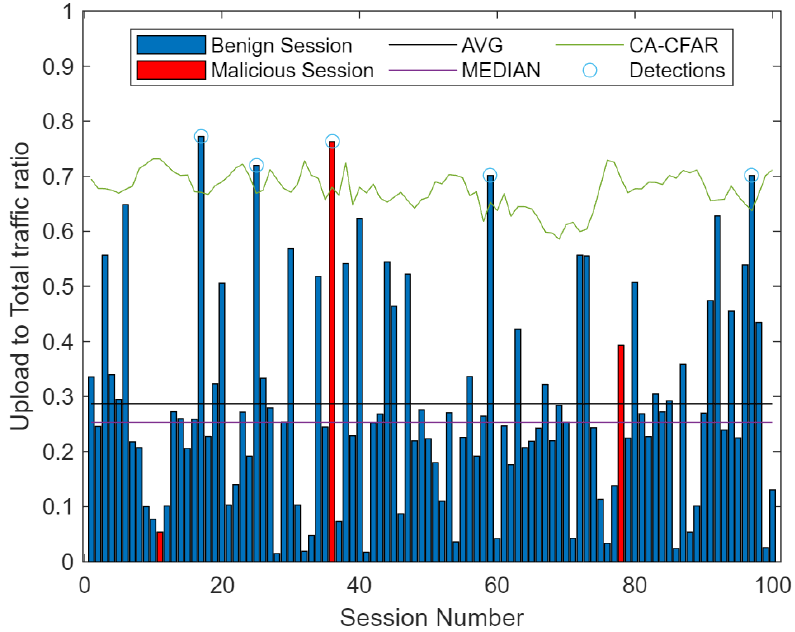
Figure 17. The designated threshold for 40 training cells and 2 guards cells. Upload